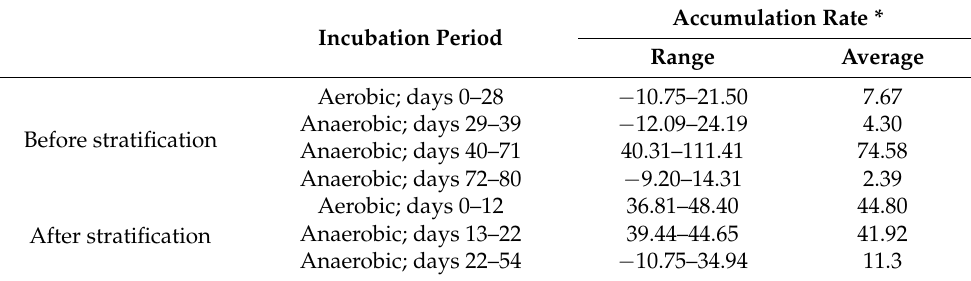
Figure 6. Ammonia nitrogen in the overlying water of in situ experimental reactor over time. ( A ) Before stratification. ( B ) After stratification. Table 1. Accumulation rates of ammonia in the in situ experimental chambers.